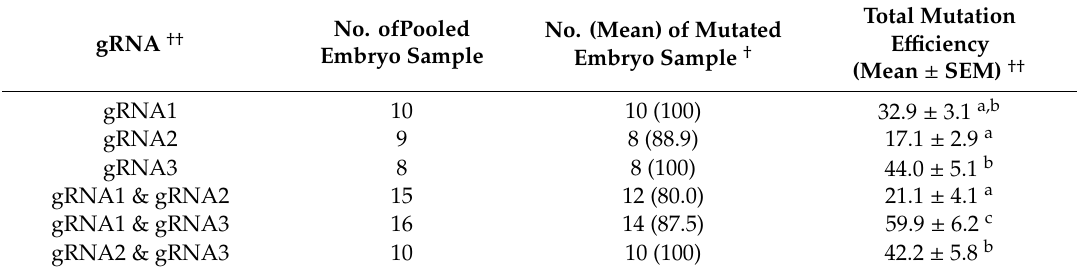
Table 3. Mutation rate and e ffi ciency in pooled embryos at the 2-to-8-cell stage derived from zygotes that had been electroporated with three di ff erent gRNAs targeting the PERV pol gene, either alone or in combination.